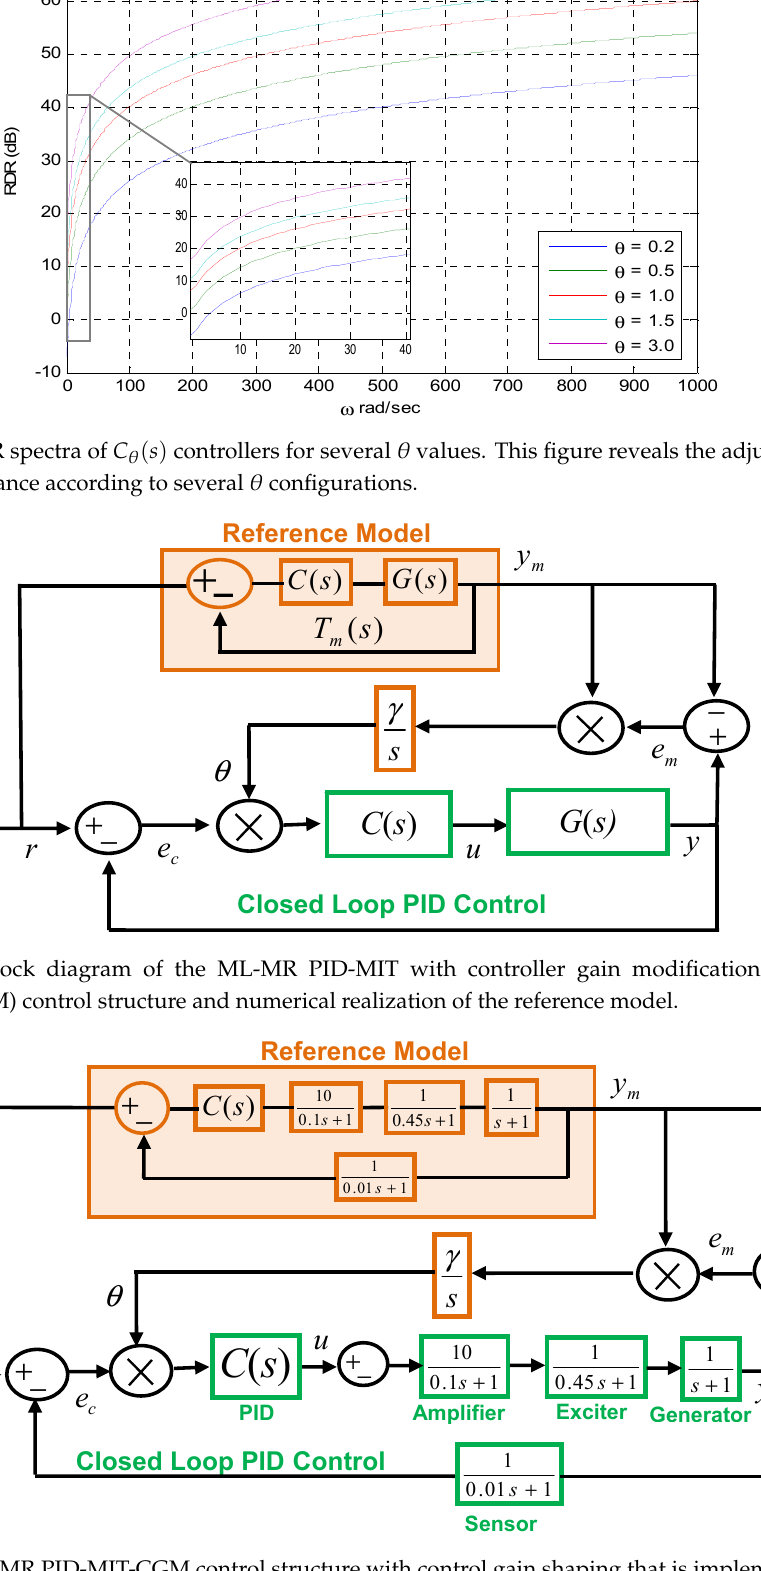
Figure 5. RDR spectra of )( sC θ controllers for several θ values. This figure reveals the adjustment of RDR performance according to several θ configurations.